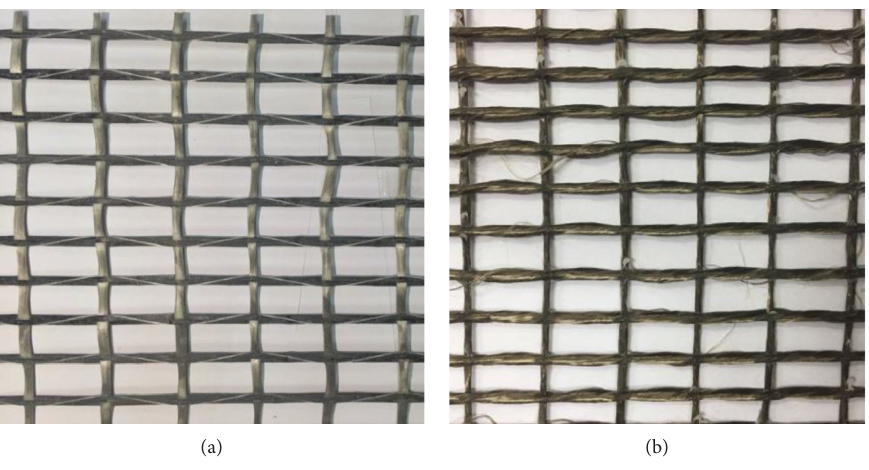
Figure 3: FRP fabrics. (a) CFRP fabric. (b) BFRP fabric.